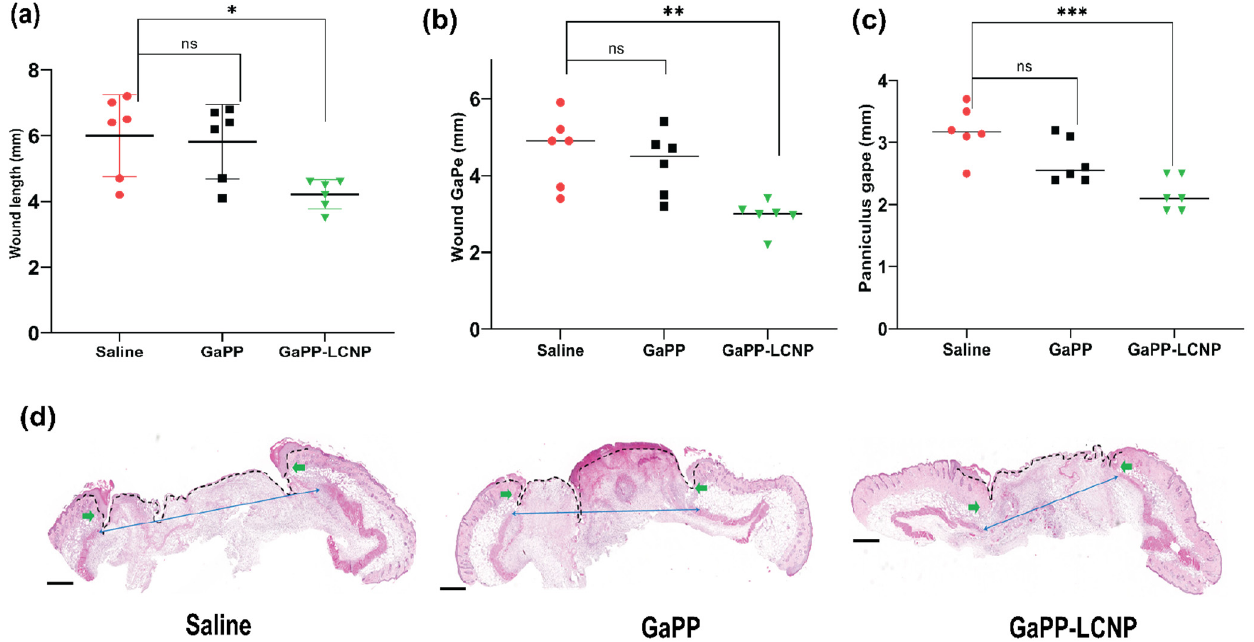
Figure 11. Microscopic analysis of the wound-healing process using histology analysis. ( a ) represents wound length, ( b ) wound gape and ( c ) panniculus gape; ( d ) representative histology section used for the obtained measurements; the dotted black line represents wound length, green arrows represent wound gape and blue arrows represent panniculus gape; magnification 10× H&E stain. Data presented as mean ± SD compared to control treated with saline; ns: non-significant, * p value = 0.01, ** p = 0.002 and *** p = 0.0003 (one-way ANOVA test followed by multiple comparison Dunnett’s test).